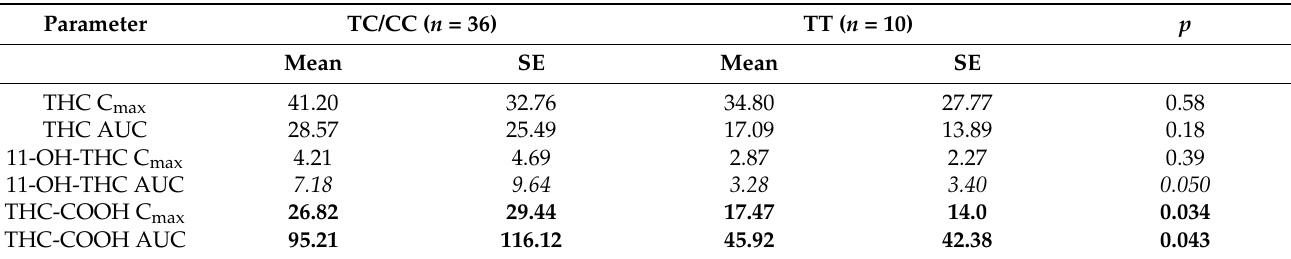
Table 2. Pharmacokinetic